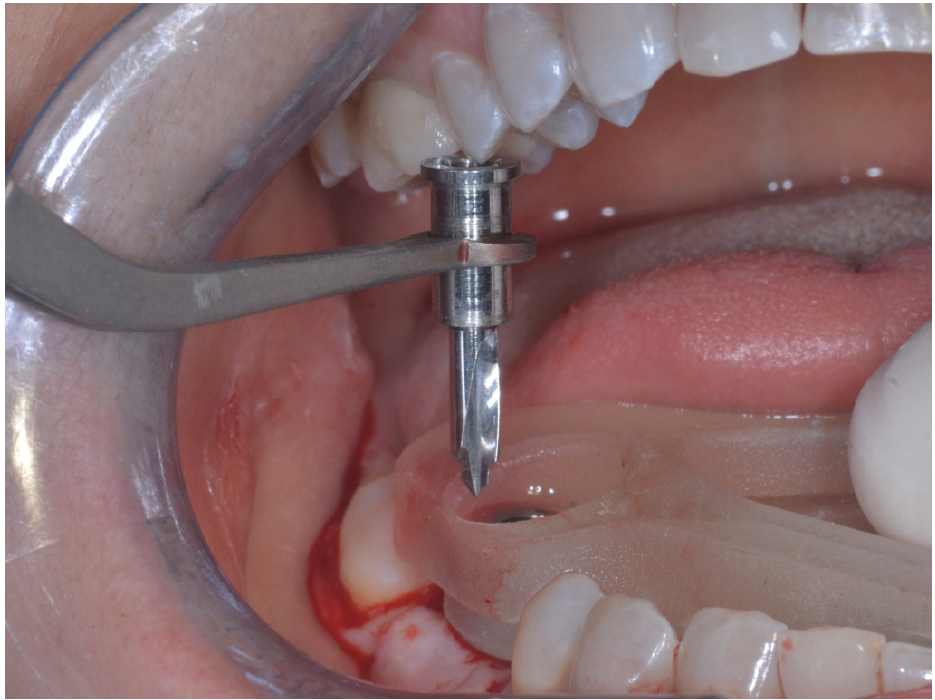
Figure 11. Intraoperative view of the progressive working drills (working depth 7 mm; available diameters 3 and 3.25 mm).